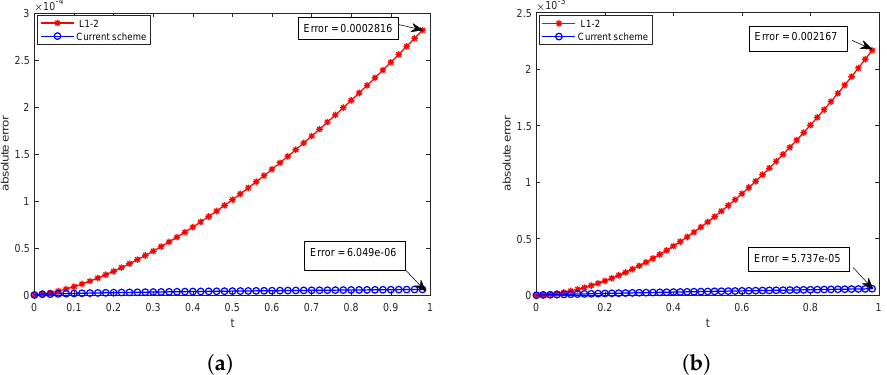
Figure 1. Error plot of the numerical results for Example 1 at final time T = 1 for different values of α (left side ( a ) for α = 0.5; right side ( b ) for α =